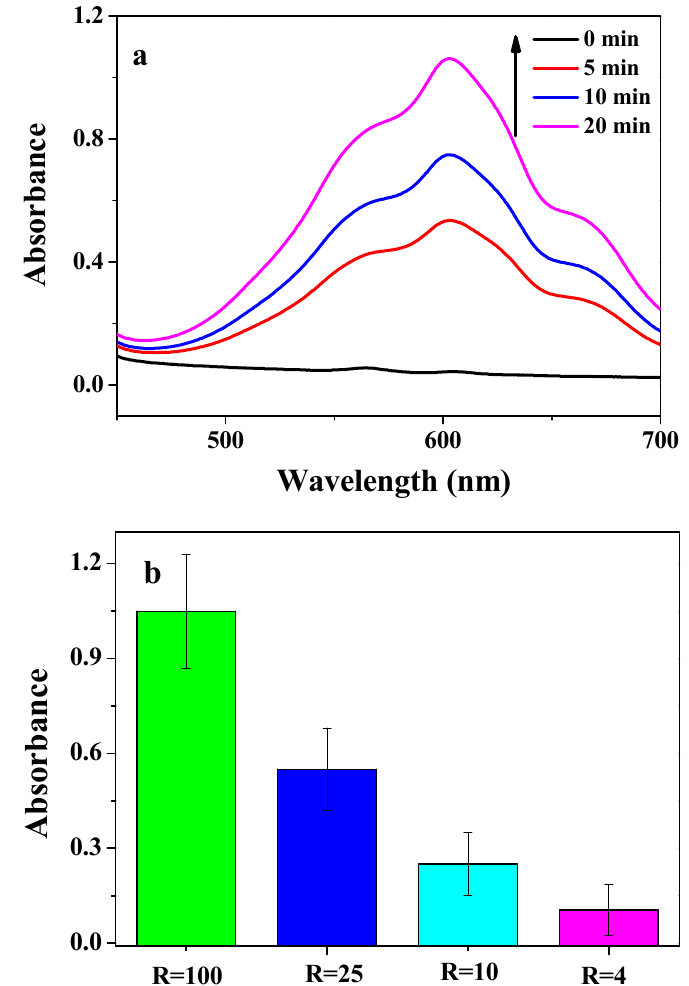
Figure 7. ( a ) Changes in the absorption spectra upon irradiation (0–20 min) of the complex micelle at R = 100 and MV 2+ . ( b ) Relative efficiency of the photoreduction with different micelles after 20 min of